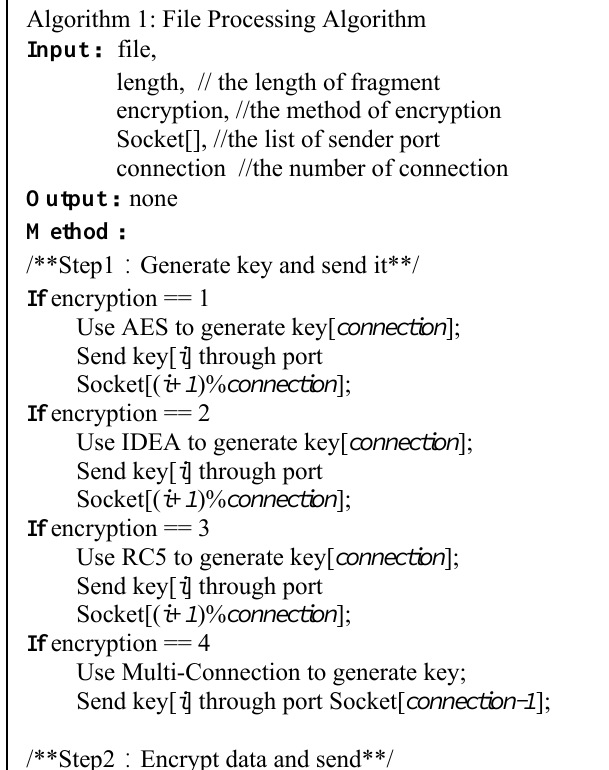
Algorithm 1: File Processing